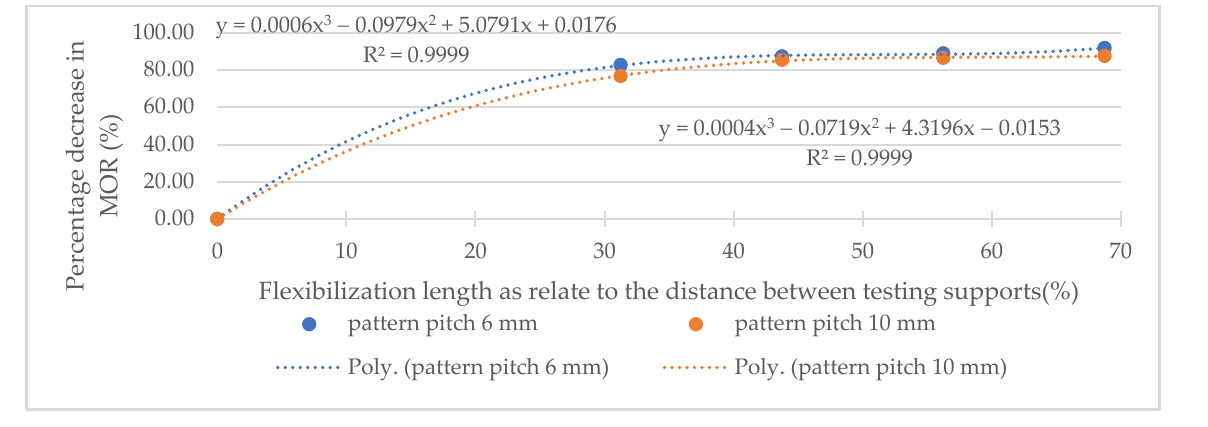
Figure 14. Correlations between percentage change in the MOE with changes in the flexibilization length, for two values of the kerfing pitch.